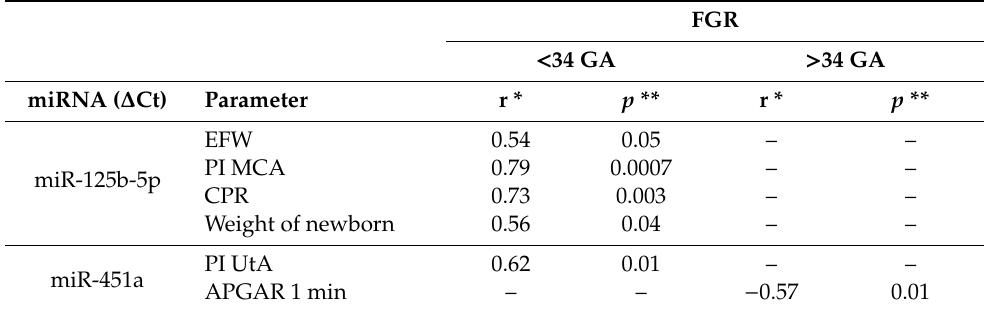
Table 4. Results of the correlation of miRNA expression level in placental tissue with Doppler measurement of pregnant women and clinical state assessments of newborns with